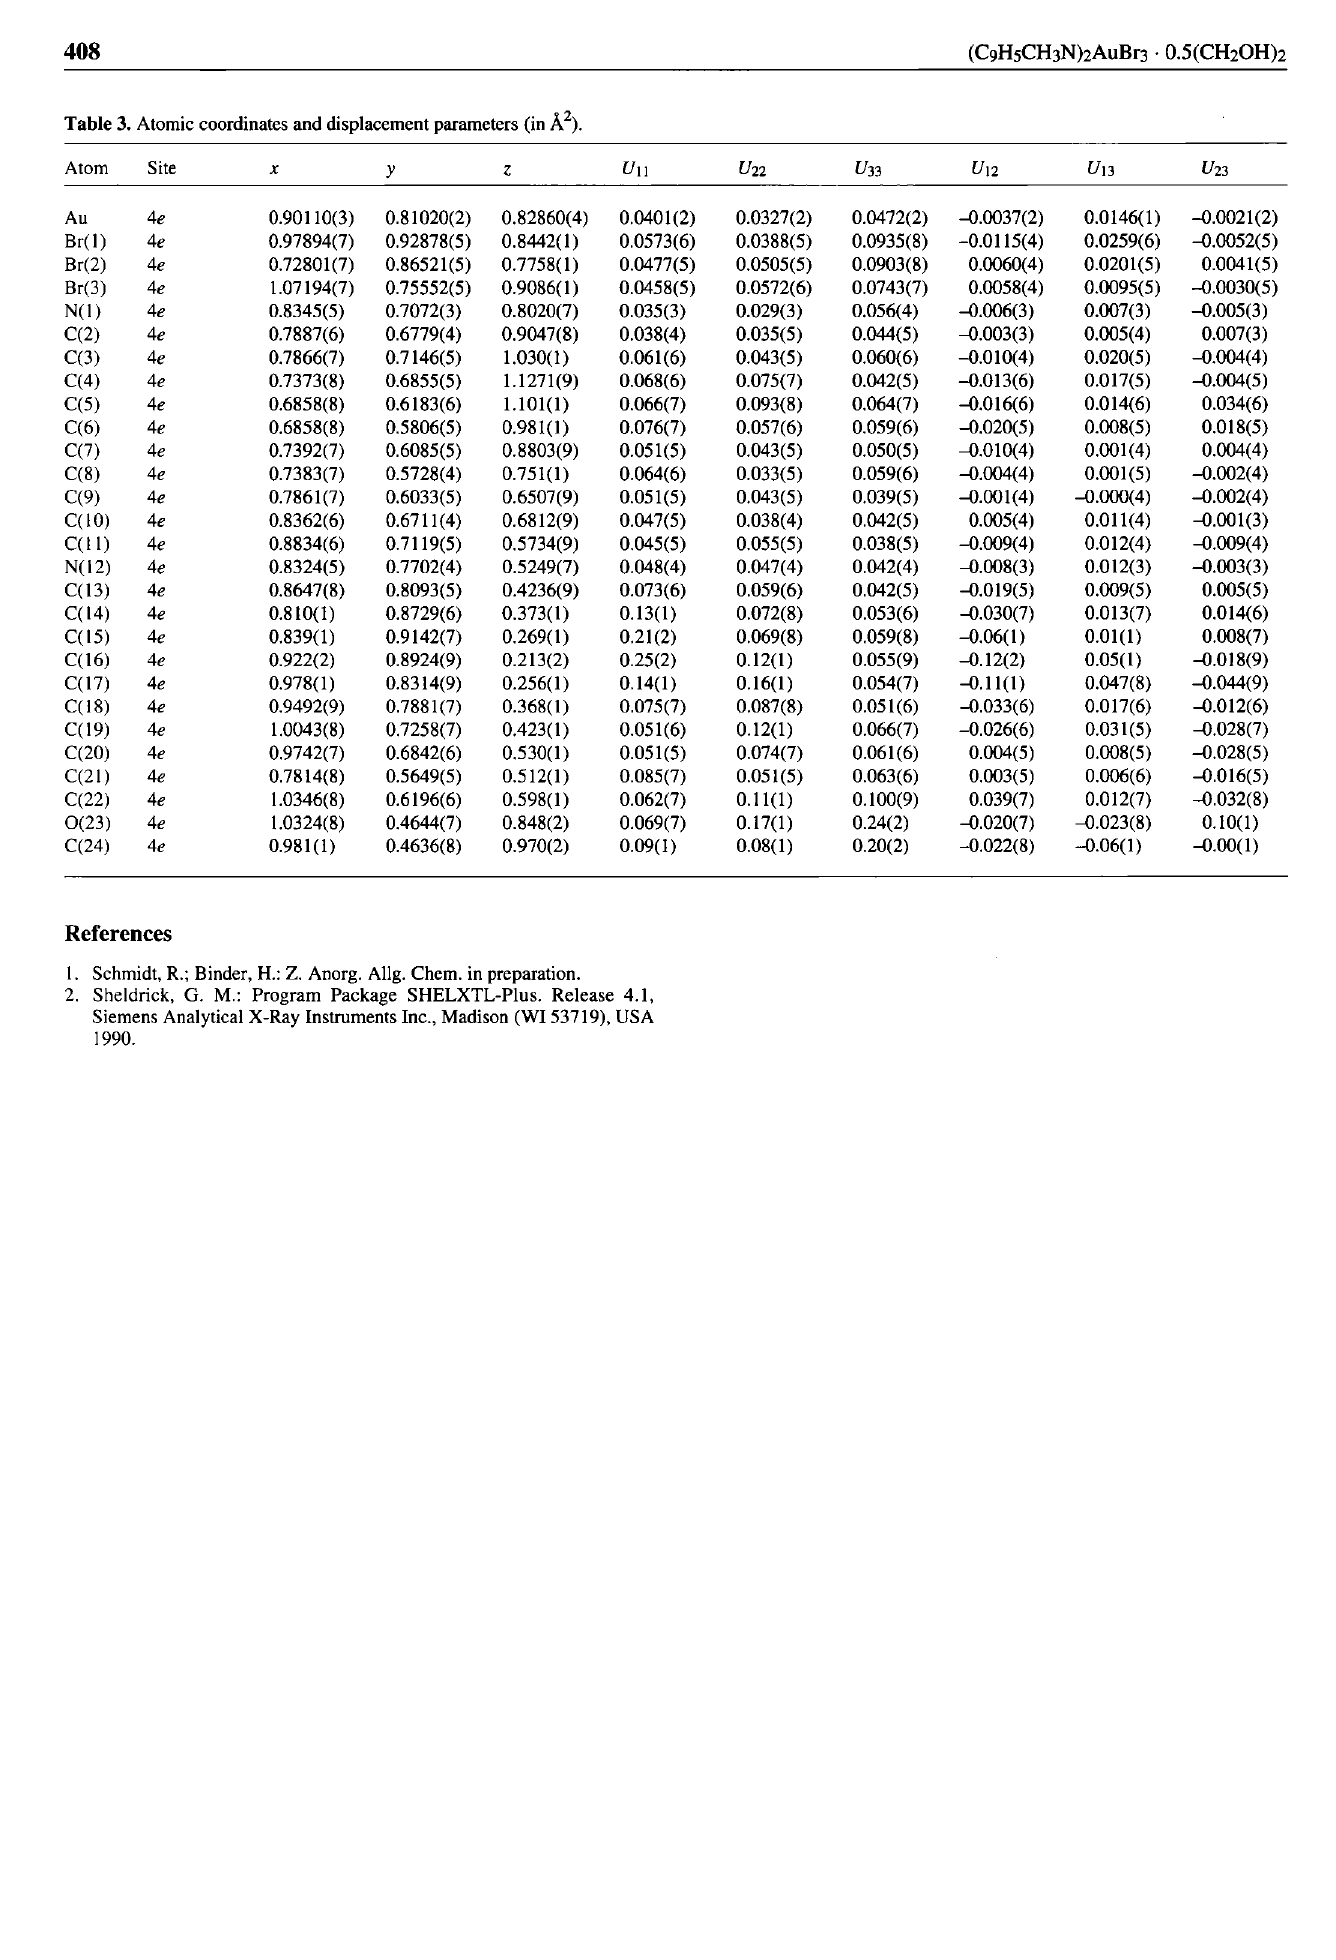
Table 3. Atomic coordinates and displacement parameters (in Ä 2